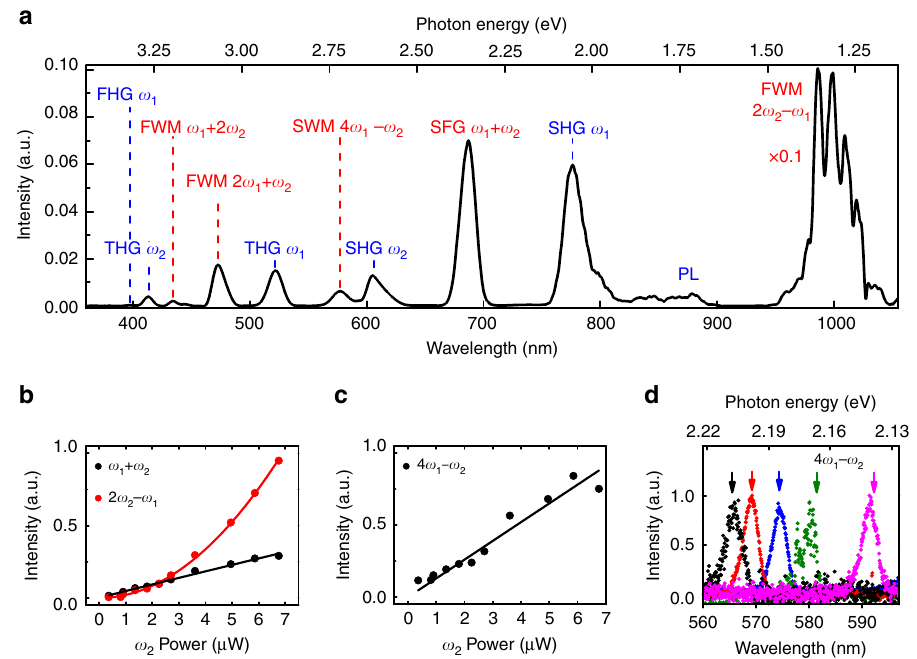
Fig. 2 Frequency mixing in GaAs metasurface. a Spectrum exhibiting eleven nonlinearly generated peaks originating from seven different nonlinear processes when two optical beams at λ 2 ~ 1.24 μ m and λ 1 ~ 1.57 μ m are used to simultaneously pump the GaAs metasurface. Blue labels indicate harmonic generation processes and photoluminescence arising from two-photon absorption that each requires only one pump beam. Red labels indicate frequency mixings that involves both pump beams. b , c Dependence of the sum-frequency generation ð ω 1 þ ω 2 Þ , four-wave mixing ð 2 ω 2 (cid:2) ω 1 Þ , and six-wave mixing (4 ω 1 − ω 2 ) intensities on the power of the ω 2 pump. Both the experimental data (dots) and theoretical fi tting (black line for linear fi tting and red curve for quadratic fi tting) are shown. d Five representative spectra showing the tuning of the normalized six-wave mixing ð 4 ω 1 (cid:2) ω 2 Þ signal when the pump wavelengths are spectrally tuned to λ 2 ~ 1248.7nm, λ 1 ~ 1557.5 nm (black curve); λ 2 ~ 1234.8 nm, λ 1 ~ 1558.6nm (red curve); λ 2 ~ 1211.6 nm, λ 1 ~ 1558.9 nm (blue curve); λ 2 ~1234.9 nm, λ 1 ~ 1581.2 nm (green curve); and λ 2 ~ 1233.7 nm, λ 1 ~ 1600.4 nm (magenta curve). The arrows denote the theoretically